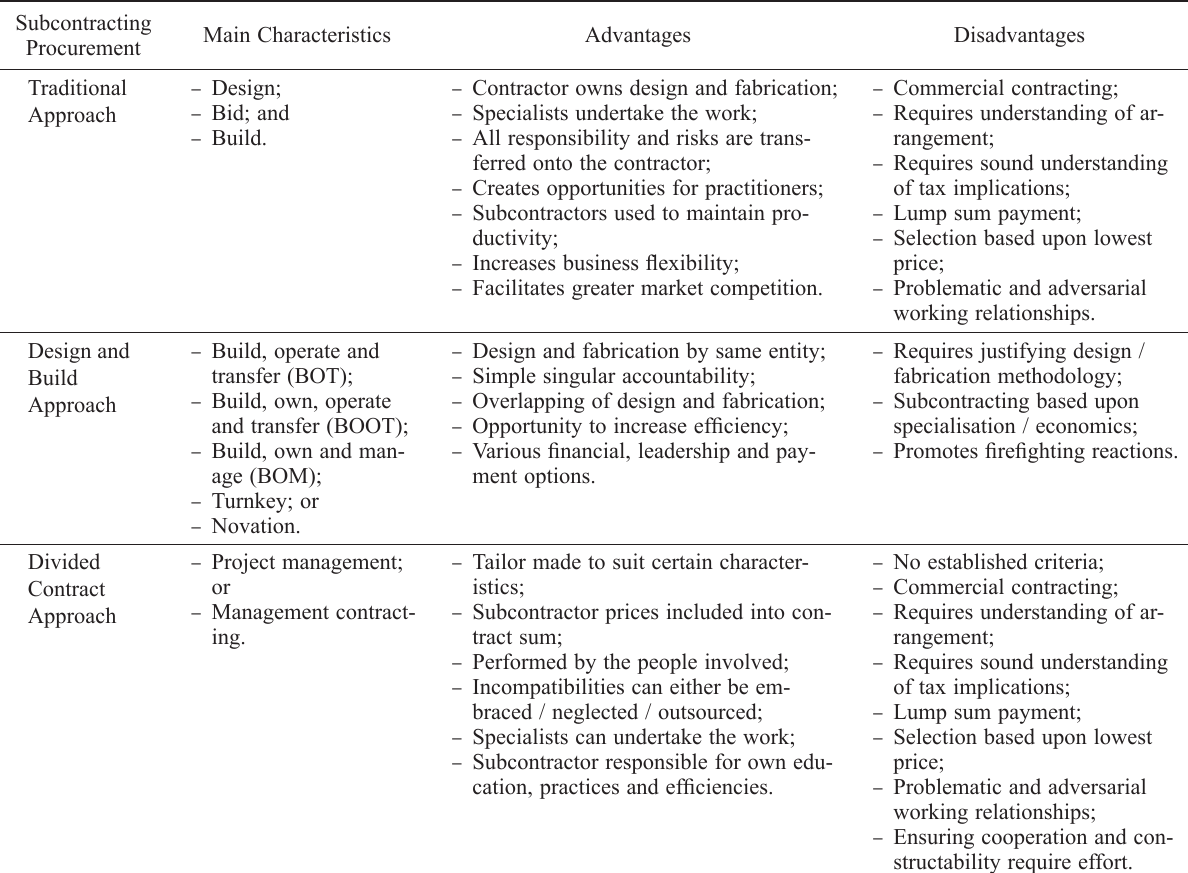
Table 1. Characteristics of subcontracting procurement